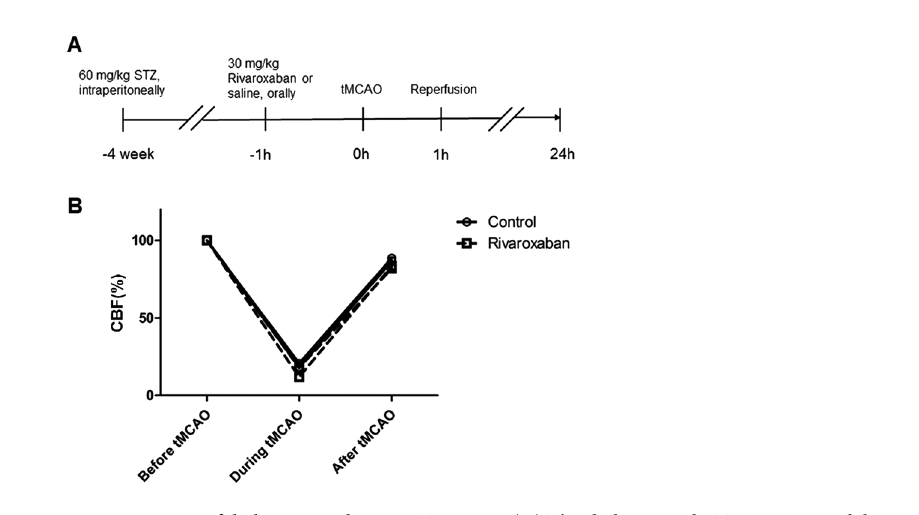
Figure 1. CBF of diabetic rats during ET surgery. ( A ) The diabetes and ET tMCAO model in rats. Rats received 60 mg/kg streptozotocin (STZ) intraperitoneally. Four weeks later, the rats received 30 mg/kg Rivaroxaban or saline orally. ( B ) Laser Doppler measurements during tMCAO surgery in diabetic control rats (n = 33, full line) and Rivaroxaban-treated diabetic rats (n = 33, dash line).